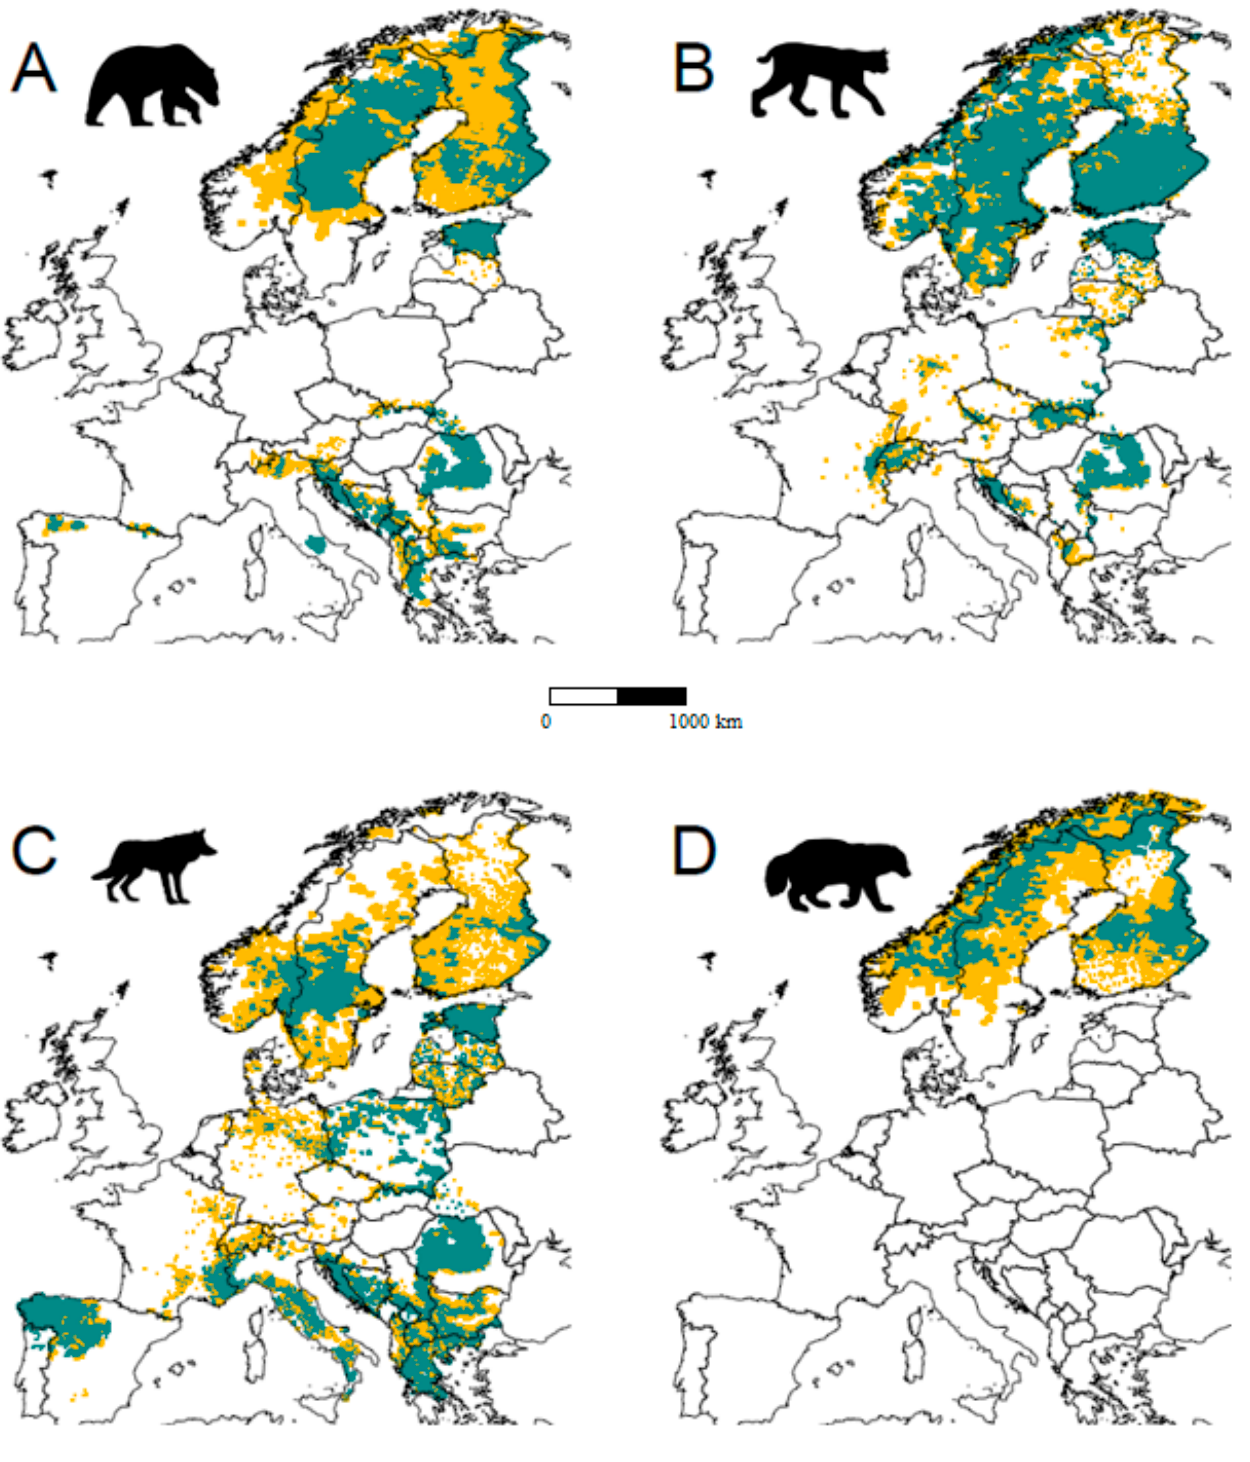
Figure 1. Permanent (green) and sporadic (orange) occurrences of ( A ) brown bear, ( B ) Eurasian lynx, ( C ) grey wolf and ( D ) wolverine in Europe estimated by [38]. Country borders in black. Large carnivore black icons from https://www.lcie.org/Large-carnivores (accessed on 20 September 2022).